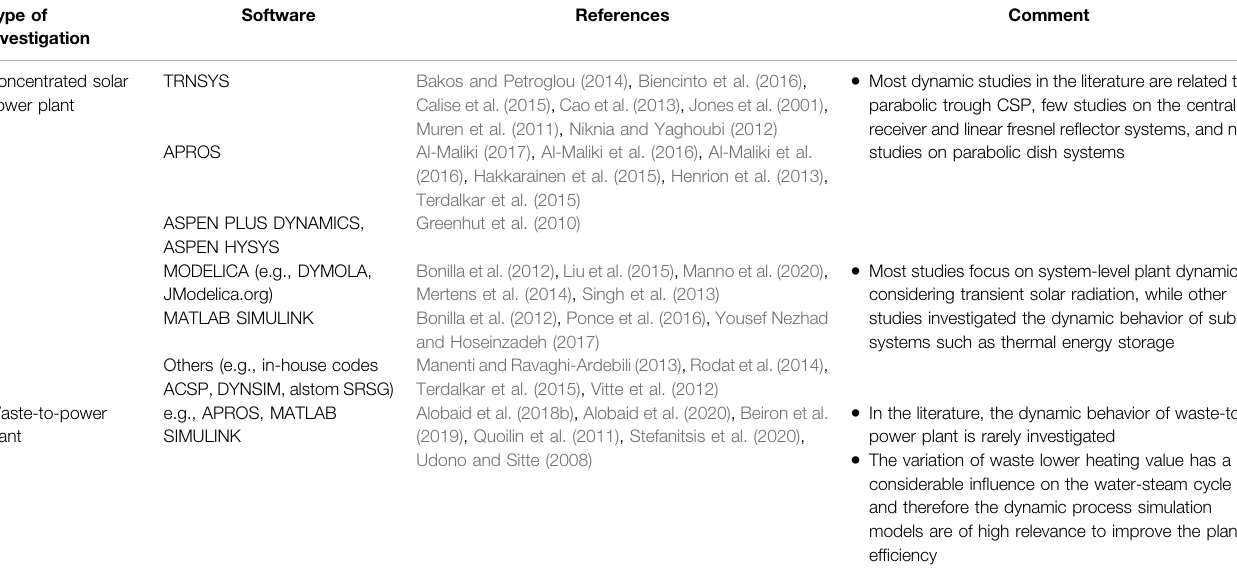
TABLE 6 | Overview of dynamic simulation studies applied to concentrated solar power plants, geothermal power plants, and waste-to-power